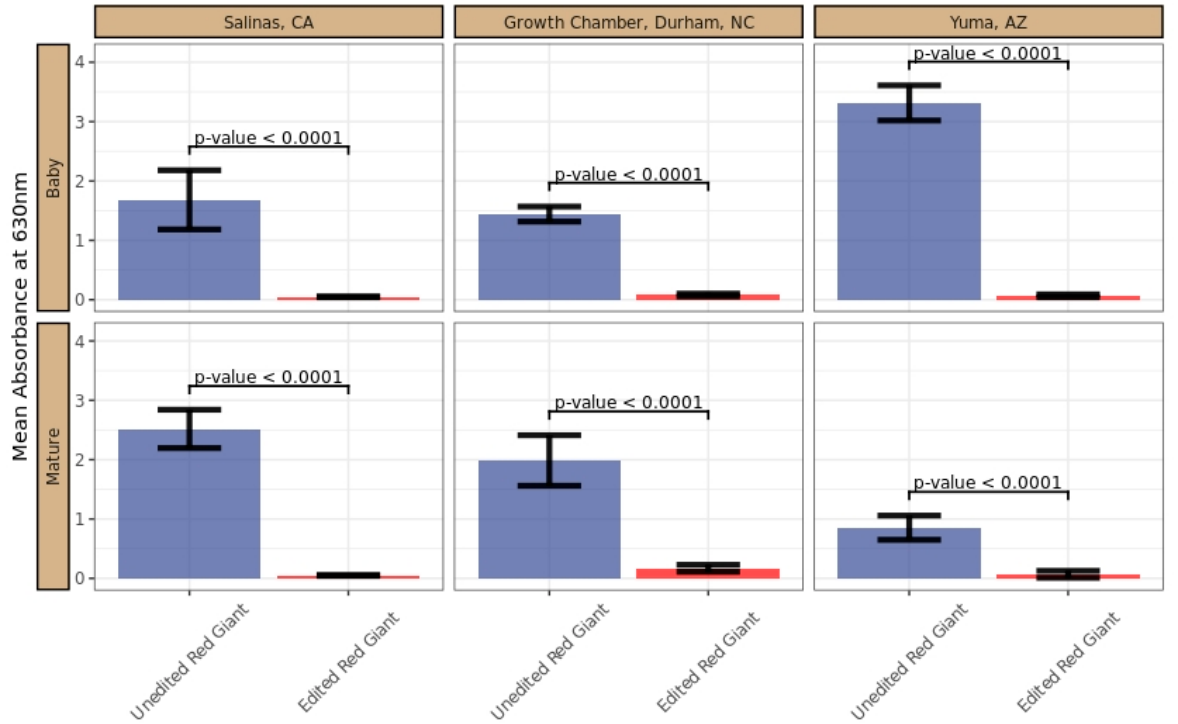
Figure 5. Glucose release assay of unedited vs. edited Brassica juncea . Mean glucose release absorbance (GRA) values at 630 nm from leaf discs in the presence of sinigrin for unedited and edited Red Giant mustard cultivars by environment and harvest stage (Figure S1). Error bars represent the standard error for the mean GRA value. The p -value is for the post hoc two-tailed pairwise comparison between the edited and unedited cultivar (Tables S3 and S4). Leaf samples were randomly selected from harvested material. Data values are the GRA colorimetric absorbance values at 630 nm from leaf discs processed in the presence of sinigrin.